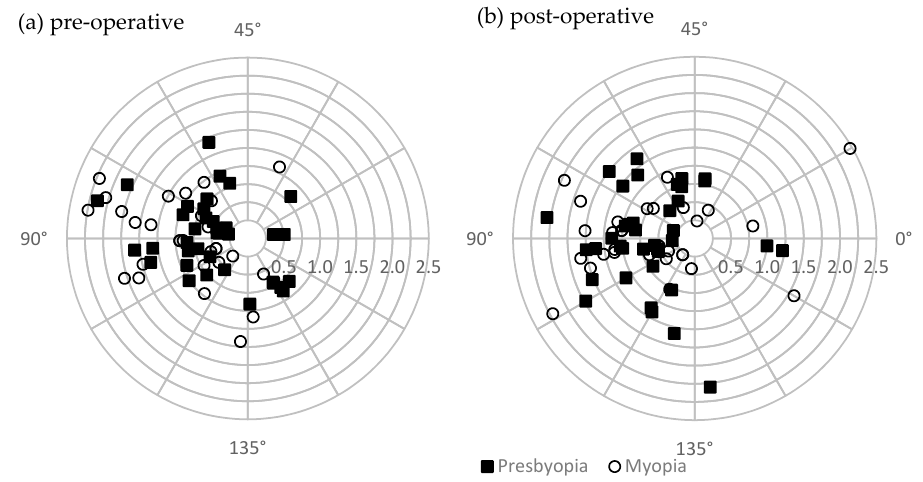
Figure 2. Double-angle polar plots comparing ( a ) pre- to ( b ) postoperative astigmatism. Myopia results are shown as circles and presbyopia results are shown as solid squares. No obvious differences between myopia and presbyopia correction were visible.